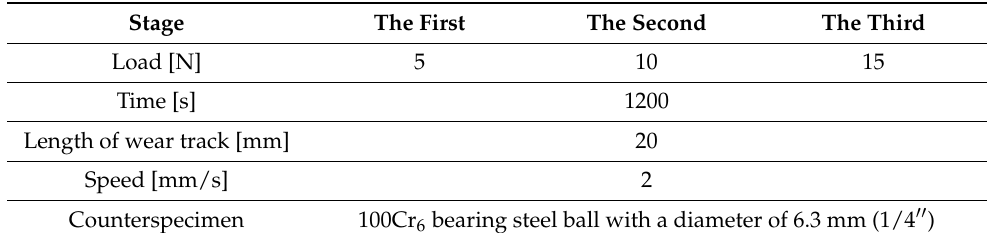
Table 4. Parameters of tribological tests. Stage The First The Second The